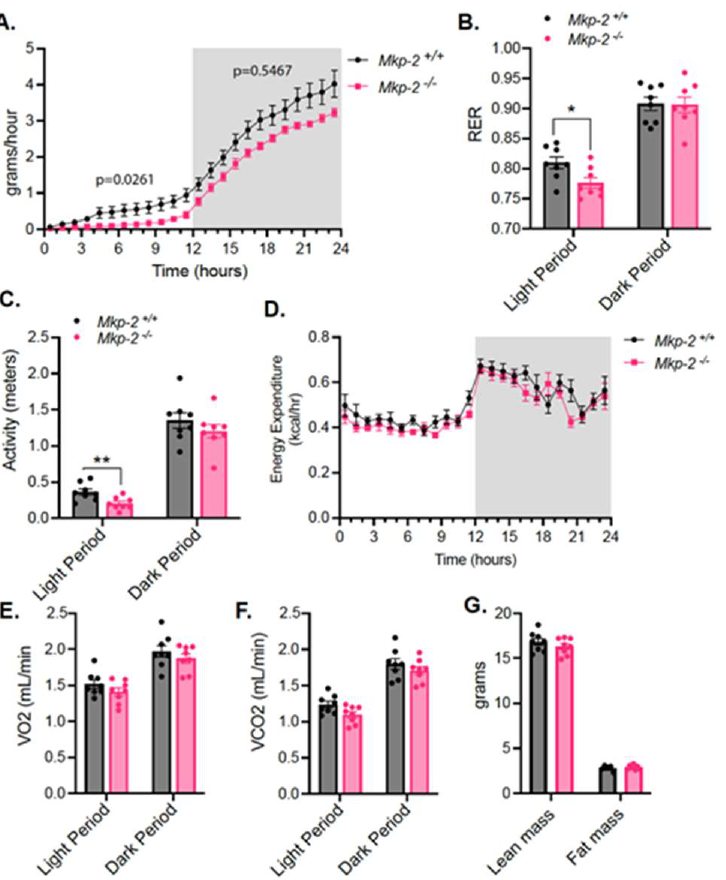
Figure 4. Reduced food intake and RER in MKP-2-deficient mice. ( A – G ) Chow-fed Mkp-2 +/+ and Mkp-2 − / − mice were subjected to indirect calorimetry. ( A ) Food intake; ( B ) respiratory exchange ratio; ( C ) locomotor activity; ( D ) energy expenditure; ( E ) oxygen consumption; ( F ) carbon dioxide production; and ( G ) lean and fat mass (N = 8 per genotype). Data represent mean ± SEM * p < 0.05, ** p < 0.01, as determined by Student’s t -test or by ANCOVA analysis. 3.6. Protection from the Development of Hepatic Steatosis in MKP-2-Deficient Mice Consequent to HFD feeding for 24 weeks, lipid content were markedly decreased in the livers of male MKP-2-deficient mice as compared with Mkp-2 +/+ , mice, suggesting that MKP-2 deficiency prevents the development of hepatic steatosis (Figure 5A, upper panel Mkp-2 − / − , lower panel Mkp-2 +/+ ). No differences were observed histologically or in tissue weights in the liver, skeletal muscle, WAT, and brown adipose tissue (BAT) under chow- fed conditions (Figure S2A–E). Consistent with resistance to hepatic steatosis, Mkp-2 − / − mice exhibited a marked reduction in liver weight (Figure 5B) and hepatic triglycerides (TGs) (Figure 5C) compared with Mkp-2 +/+ mice. Furthermore, Mkp-2 − / − mice exhibited reduced fat mass compared with Mkp-2 +/+ mice (Figure 4B). Consistent with protection from fatty liver, the expression of mRNAs for PPAR γ , sterol regulatory element-binding protein 1c (Srebf1c), and Srebf2 were significantly reduced in the livers of Mkp-2 − / − mice (Figure 5D). Under HFD feeding, important factors promoting lipogenesis in